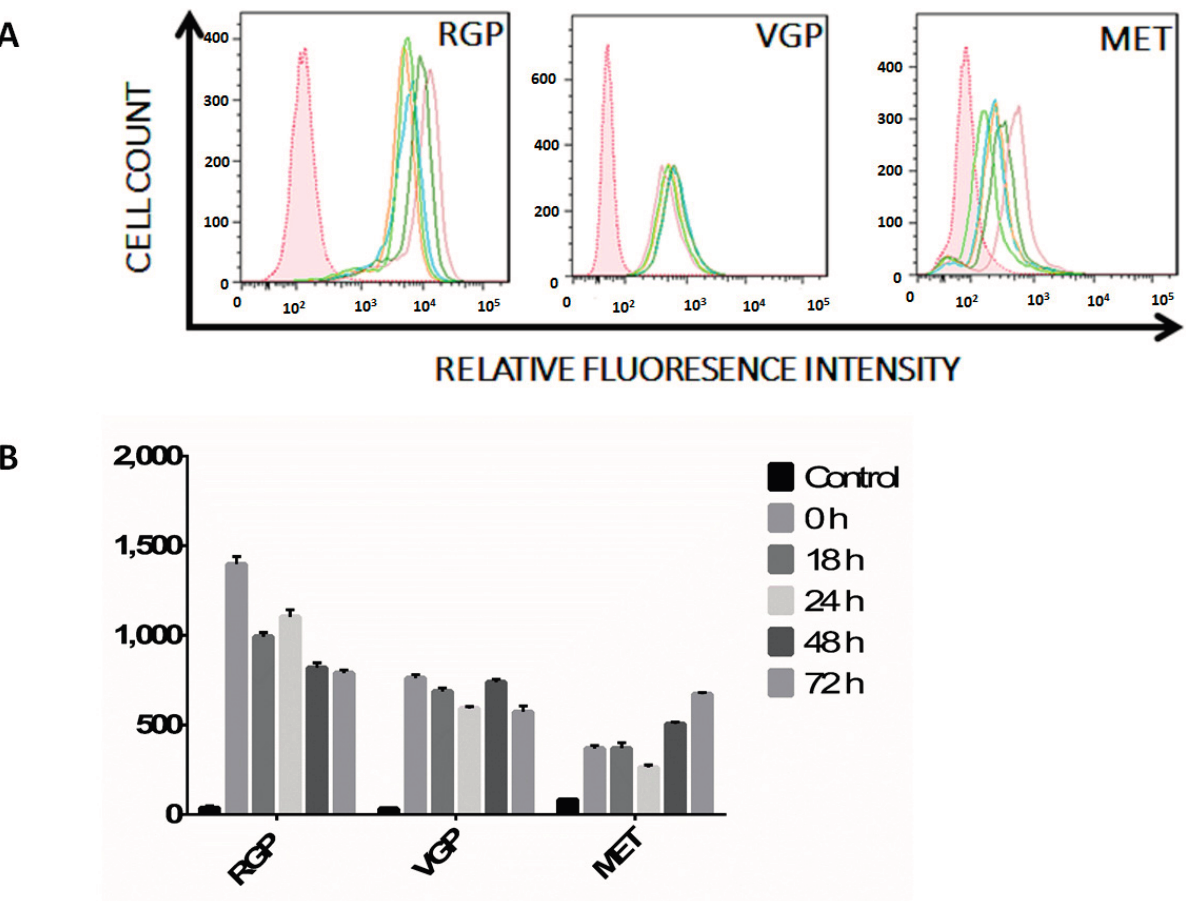
Figure 3. ( A ) Flow cytometric analysis of IFN- γ receptor expression. Cells were treated with IFN- γ for 0 h (blue), 18 h (orange), 24 h (lime green), 48 h (dark green) or 72 h (mauve). Unstained cells (shaded histogram) are shown as a control. Live cells were stained with PE-conjugated antibody against CD119 (IFN- γ R1), were fixed in 2% paraformaldehyde and were then analyzed on a Fortessa flow cytometer. RGP cells express high levels of the IFN- γ receptor as compared to the unstained control. VGP cells express low levels of the IFN- γ receptor with no change throughout 72 h of stimulation. MET cells express varying amounts of IFN- γ receptor throughout 72 h of stimulation. Changes in receptor expression between time points is not statistically significant ( p > 0.05). The data shown are representative of a minimum of three experimental replicates; ( B ) Mean fluorescence intensity of histograms seen in ( A ) normalized to the isotype control. The data shown are the average of three experimental